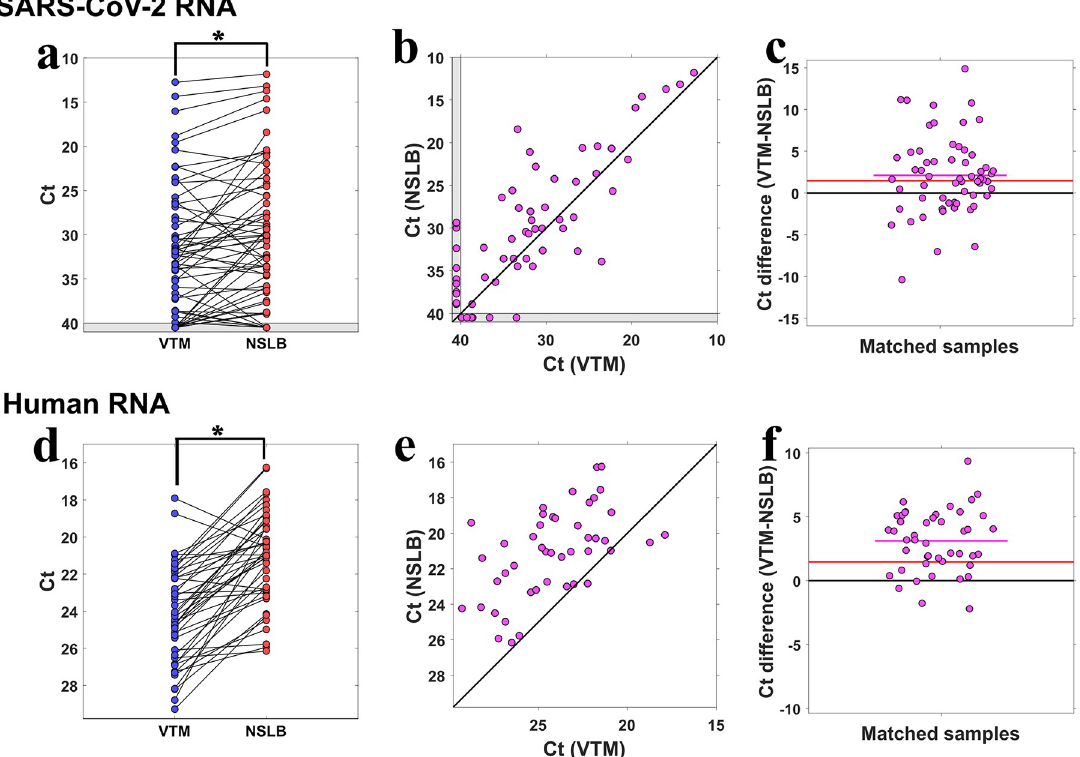
Fig 1. Comparison of sampling into VTM vs. NSLB. (a) Ct values of SARS-CoV-2 RNA in samples collected from patients into VTM (blue), linked by black lines to their NSLB matching samples from the same patients (red). The asterisk denotes a statistically significant advantage for NSLB. A grey zone adjacent to the axes marks results below the limit of detection. (b) Ct values of matched samples from the same patient in VTM (x-axis) vs. NSLB (y-axis). The diagonal black line represents theoretical equal performance of VTM and NSLB. (c) Ct difference (VTM-NSLB) for each sample pair from the same patient. The black line at y = 0 represents theoretical equal performance of VTM and NSLB. The red line at y = 1.5 represents equal performance of VTM and NSLB when controlling for VTM dilution. The magenta line shows the mean of differences. (d-f) Same as (a-c), but for human RNA.